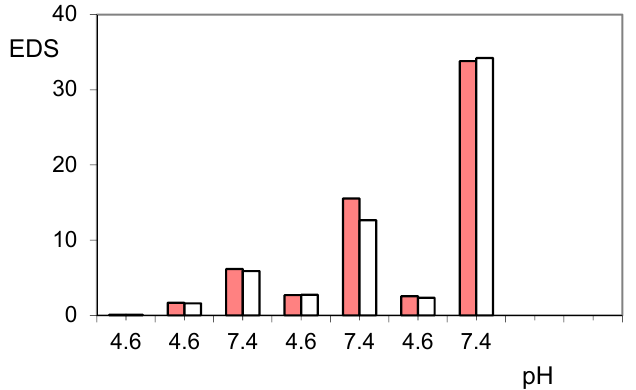
Figure 5. Equilibrium degree of swelling (EDS) of hydrogels PHE-Nip3 after releasing paroxetine at pulsed variations of buffer solutions (acetate, pH 4.60; PBS, pH 7.40) with (red bars) and without (white bars) AMF application.